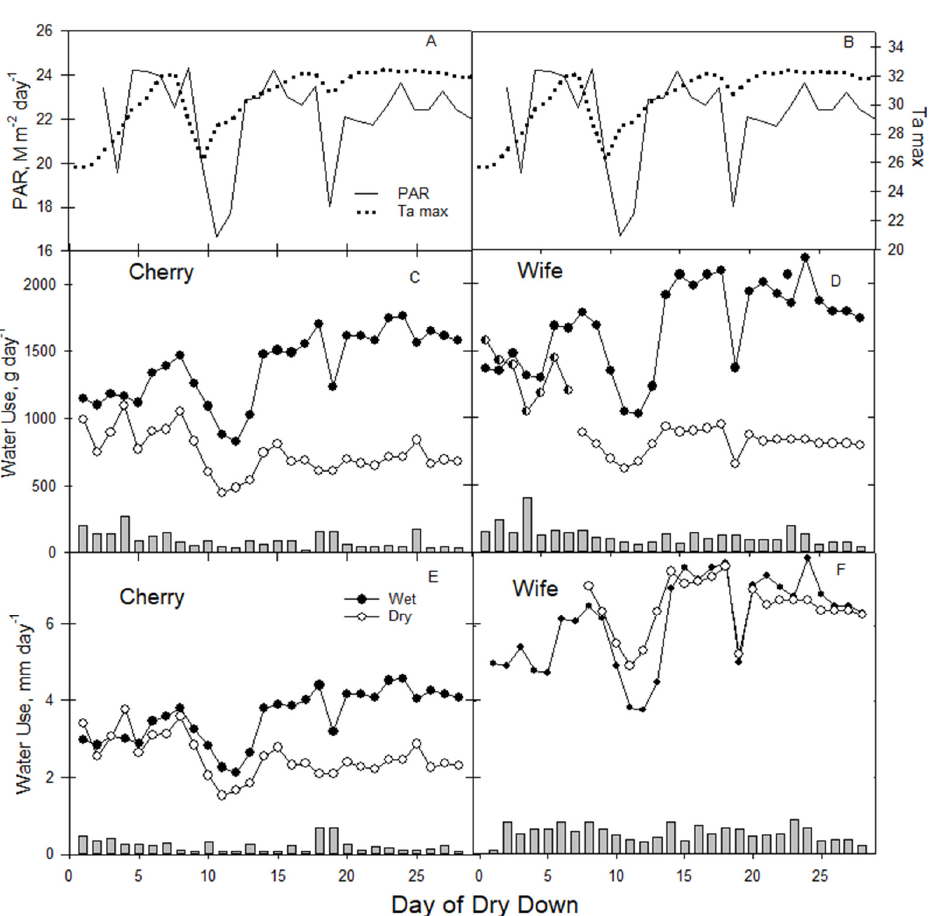
Figure 4. Water use of well-watered and water-stress hemp varieties ‘Cherry’ and ‘Wife’. ( A ) and ( B ): daily cumulative PAR and daily maximum air temperature for each day of the dry down; ( C ) and ( D ): average daily water use in grams per plant for well-watered and water-stressed ‘Cherry’ and ‘Wife’ varieties; ( E ) and ( F ): water use in mm per day (weight normalized to transpiring leaf area) for well-watered and water-stressed ‘Cherry’ and ‘Wife’ varieties. In graph ( D ) half, circle data points represent days for dry ‘Wife’ plants prior to defoliation. Bars along the X -axis of each graph are pooled standard deviation across wet and dry treatments within a cultivar ( n = 4 for each data point).